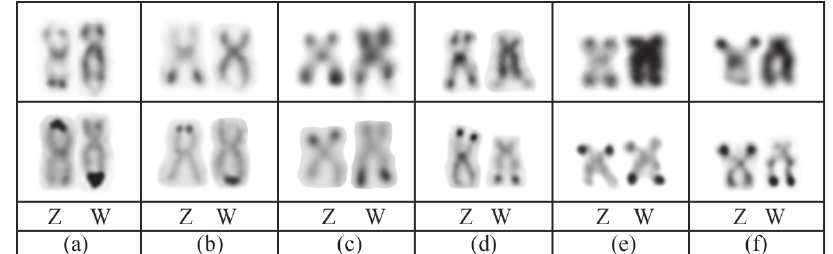
Fig. 6. Z an W sex chromosomes of the Characidium species analyzed in this study, after C-banding (first row) and silver nitrate staining (second row). Note the different distribution of the heterochromatin, mainly in the W chromosome in (a) C . schubarti , (b), Characidium sp., (c) C . pterostictum , (d) C . oiticicai , (e) C . lanei , and (f) C . lauroi